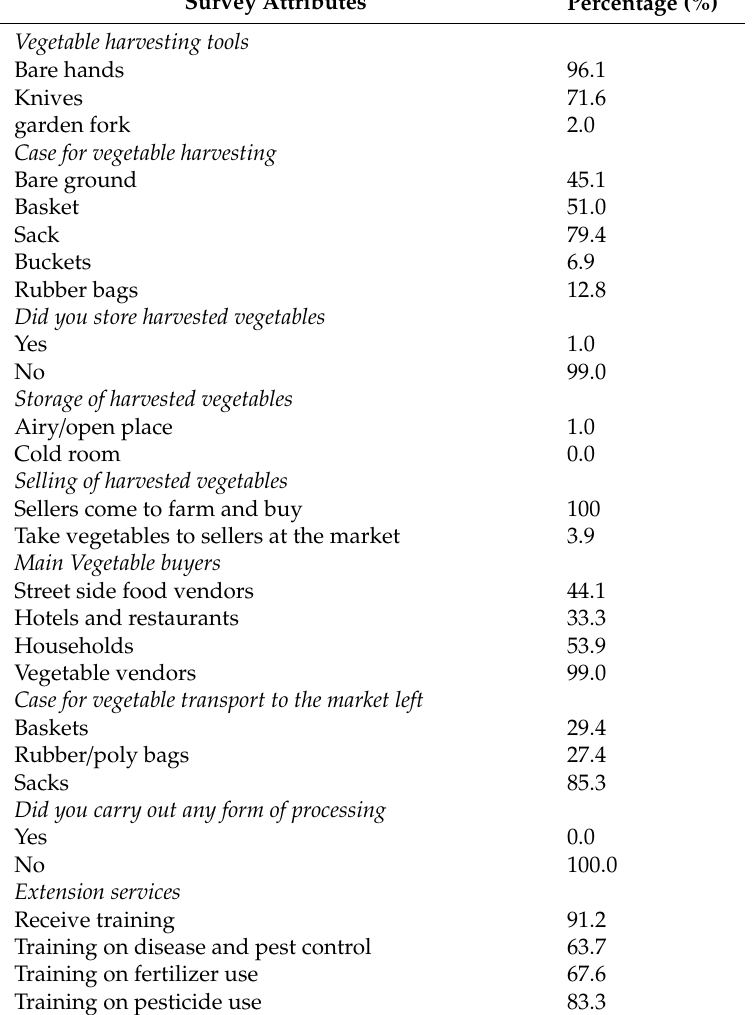
Table 5. Harvest and post-harvest practices of participating vegetable farmers in Accra, Ghana.